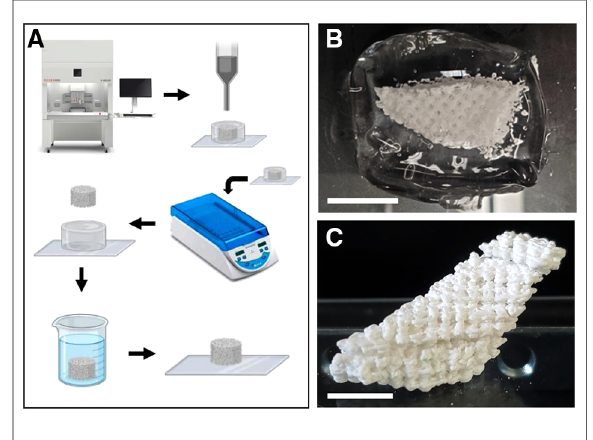
FIGURE 3 Embedded 3D printing of the core with TCP/HA paste. ( A ) Schematic depicting of the process used for printing and solidi fi cation of TCP/ HA core (for details, see the Methods section). ( B ) Half of the TCP/ HA core construct printed in Carbopol hydrogel support on a glass slide. ( C ) The cured, washed, assembled, and re-dried TCP/ HA construct. Scale bars: ( B,C ), 10